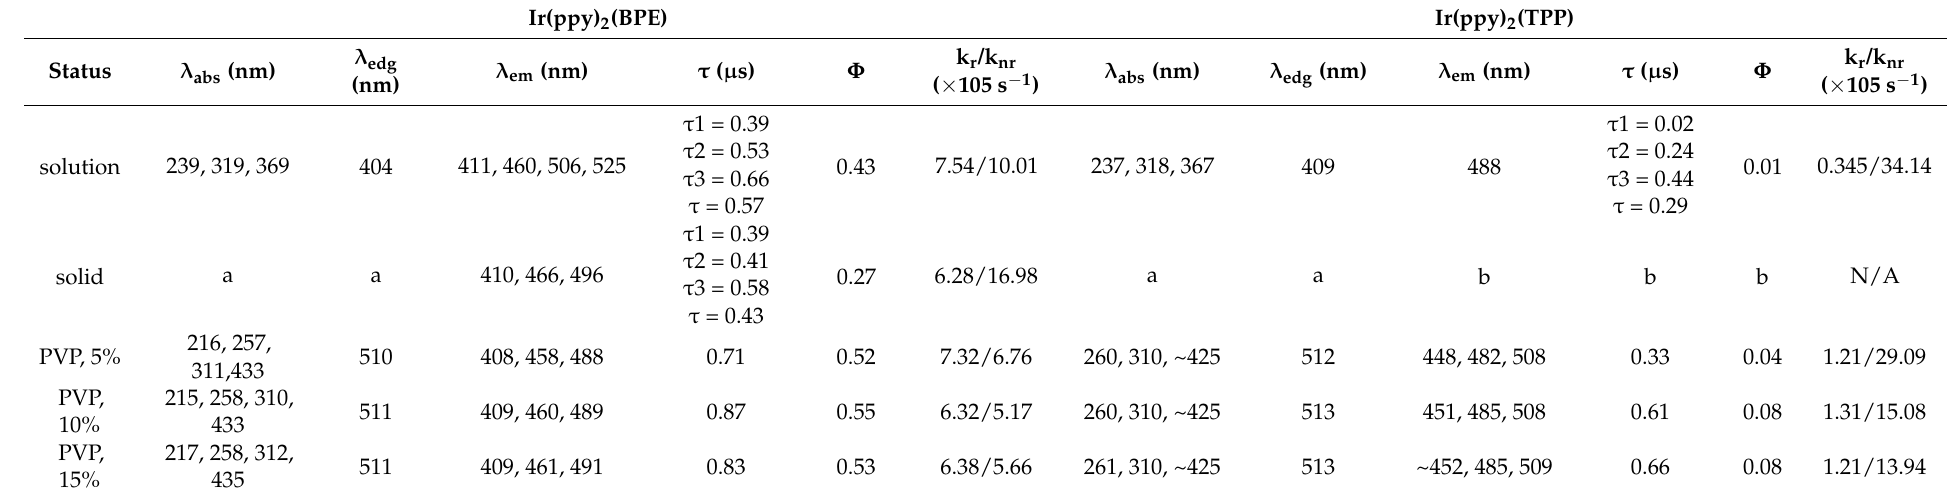
Table 2. Selected photophysical parameters of Ir(ppy) 2 (BPE) and Ir(ppy) 2 (TPP) in the solution (1 µ M), solid state, and PVP